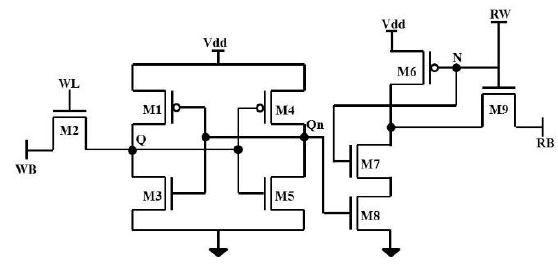
Figure 6. Traditional 9T - SRAM cell.